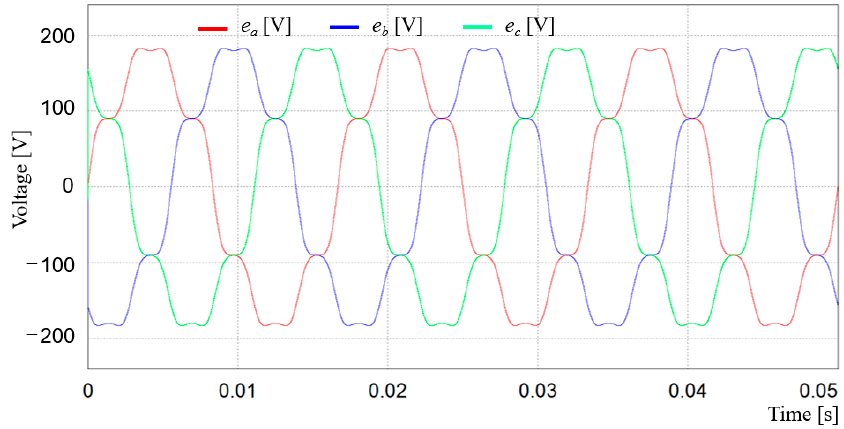
Figure 3. Distorted three-phase grid voltages.